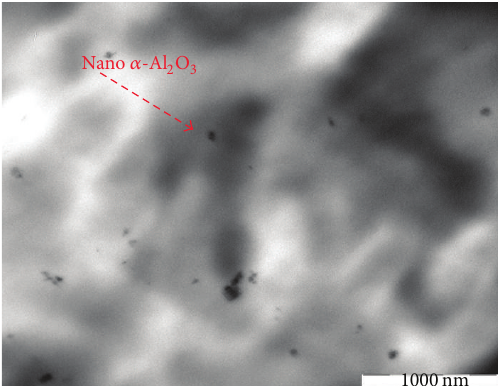
Figure 14: TEM observation of cryothin sectioning for PP/4% nano 𝛼 -Al 2 O 3 composites with dispersant.